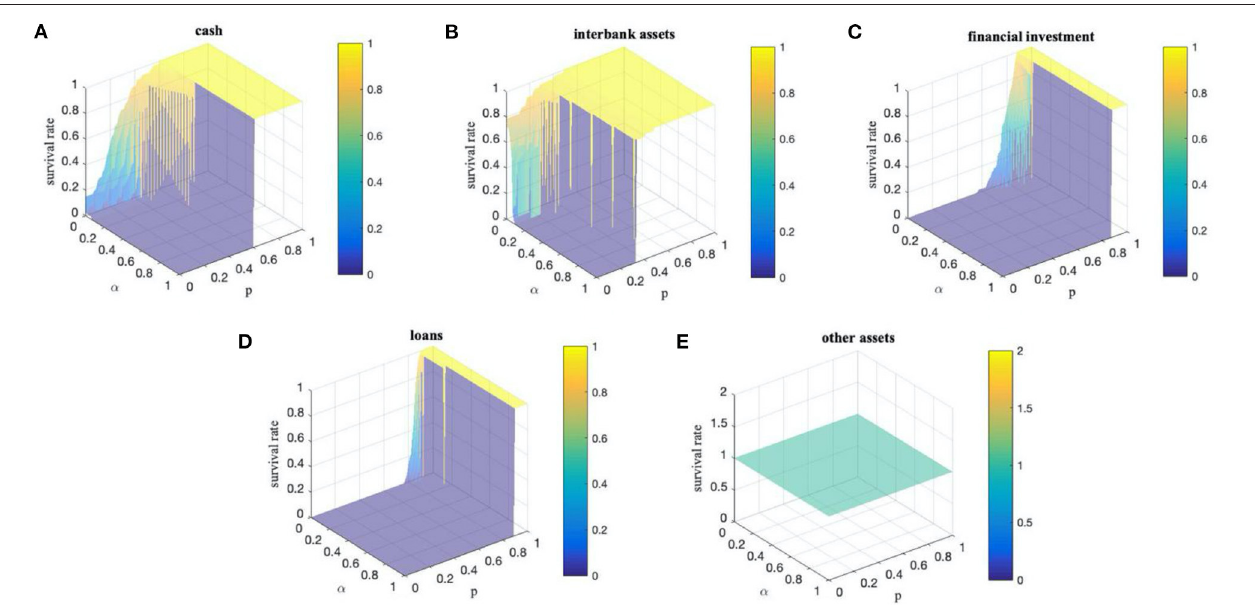
FIGURE 4 | (A–E) The survival rate of the banking system under different values of p and α when cash assets, interbank assets, financial investment assets, loan assets, and other types of assets are shocked,